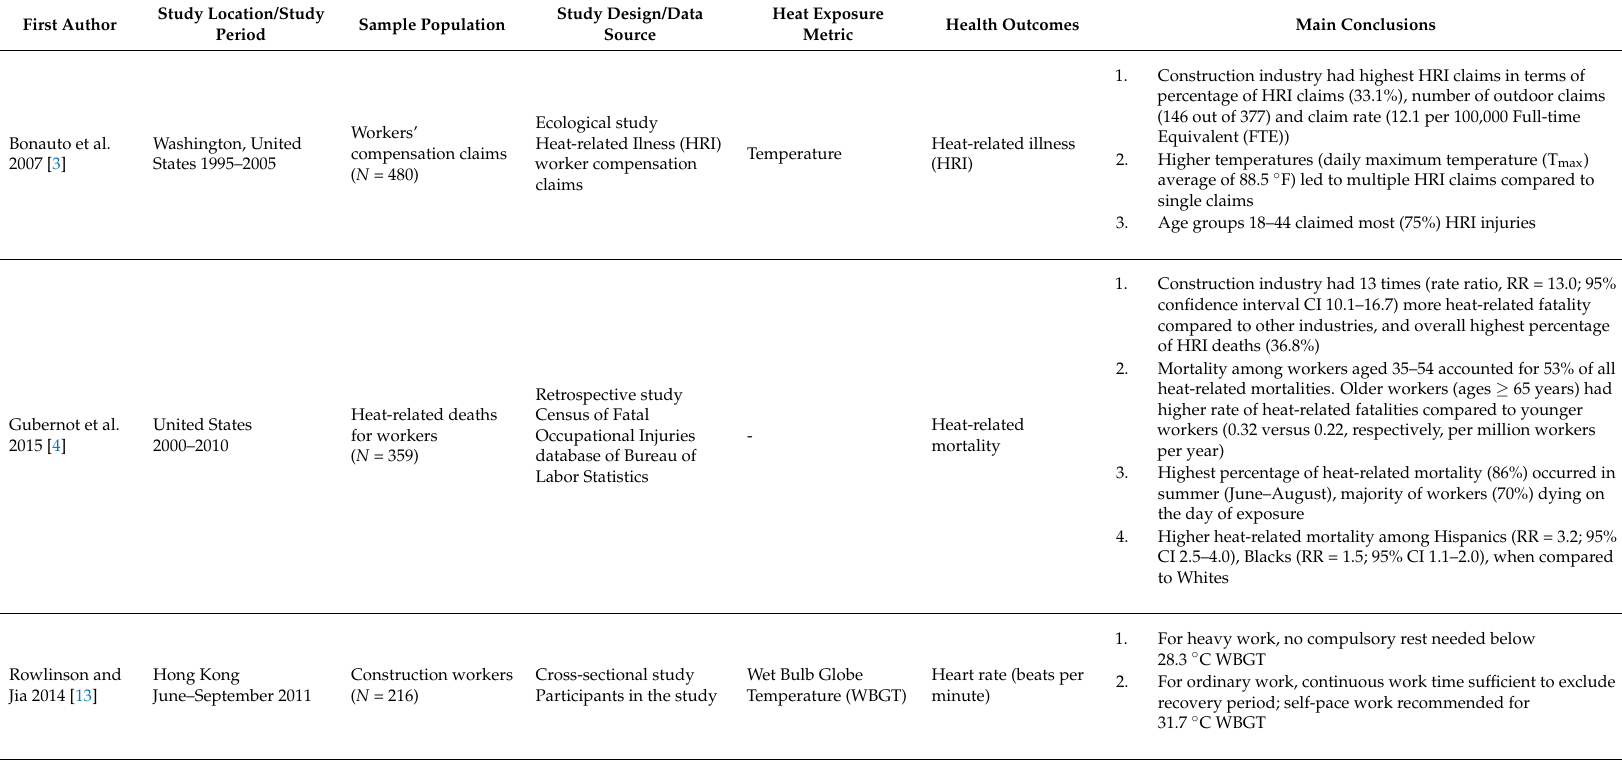
Table 1. Summary of heat-related epidemiological studies among construction